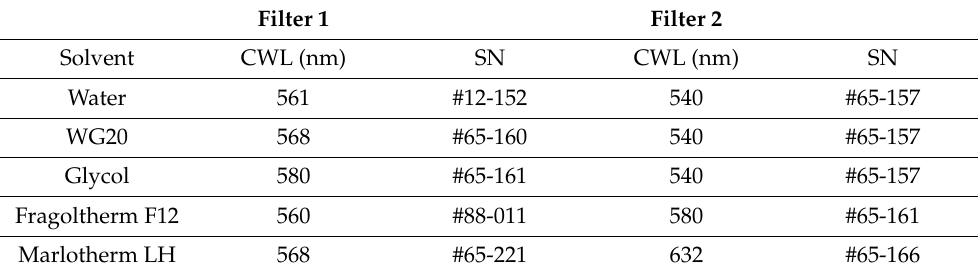
Table 4. Filter selection for temperature-sensitive intensity ratio with selected filters containing corresponding stock numbers (SN, Edmund